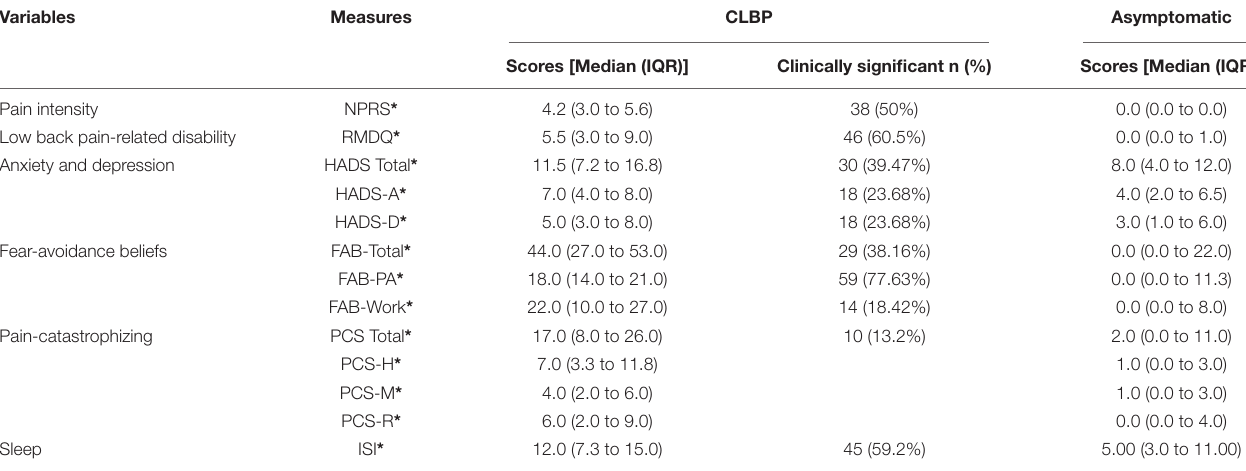
TABLE 2 | Summary of scores of psychological and sleep variables.